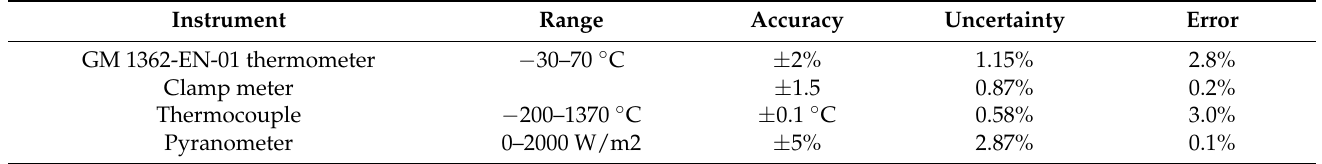
Table 2. Accuracies and uncertainties of various instruments.